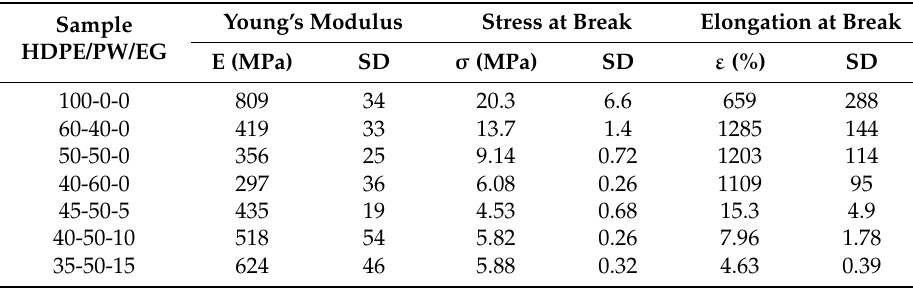
Table 2. Mechanical properties of PCMs obtained from tensile